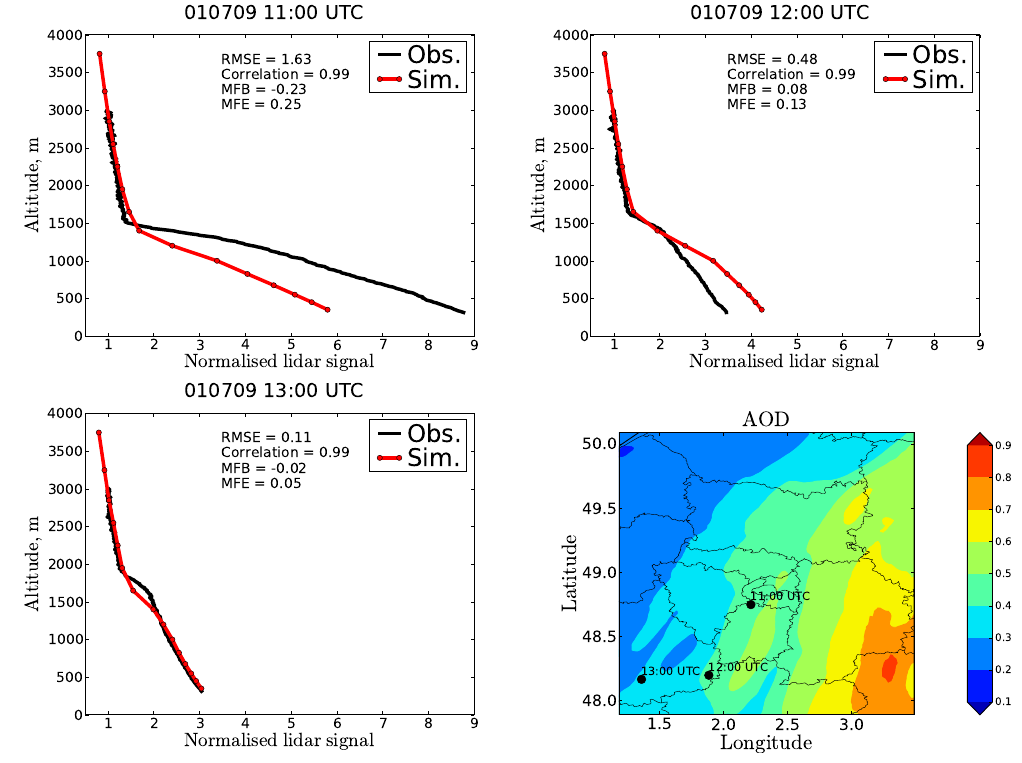
Fig. 4. Comparisons between the vertical profiles observed by GBML (black lines) and simulated by P OLYPHEMUS (red lines) on 1 July 2009 at 11:00, 12:00 and 13:00UTC. Lidar observations below the altitude of full overlap are not represented. The lower-right panel shows the positions of the different lidar profiles and the horizontal distribution of the mean of the AODs at 11:00, 12:00 and